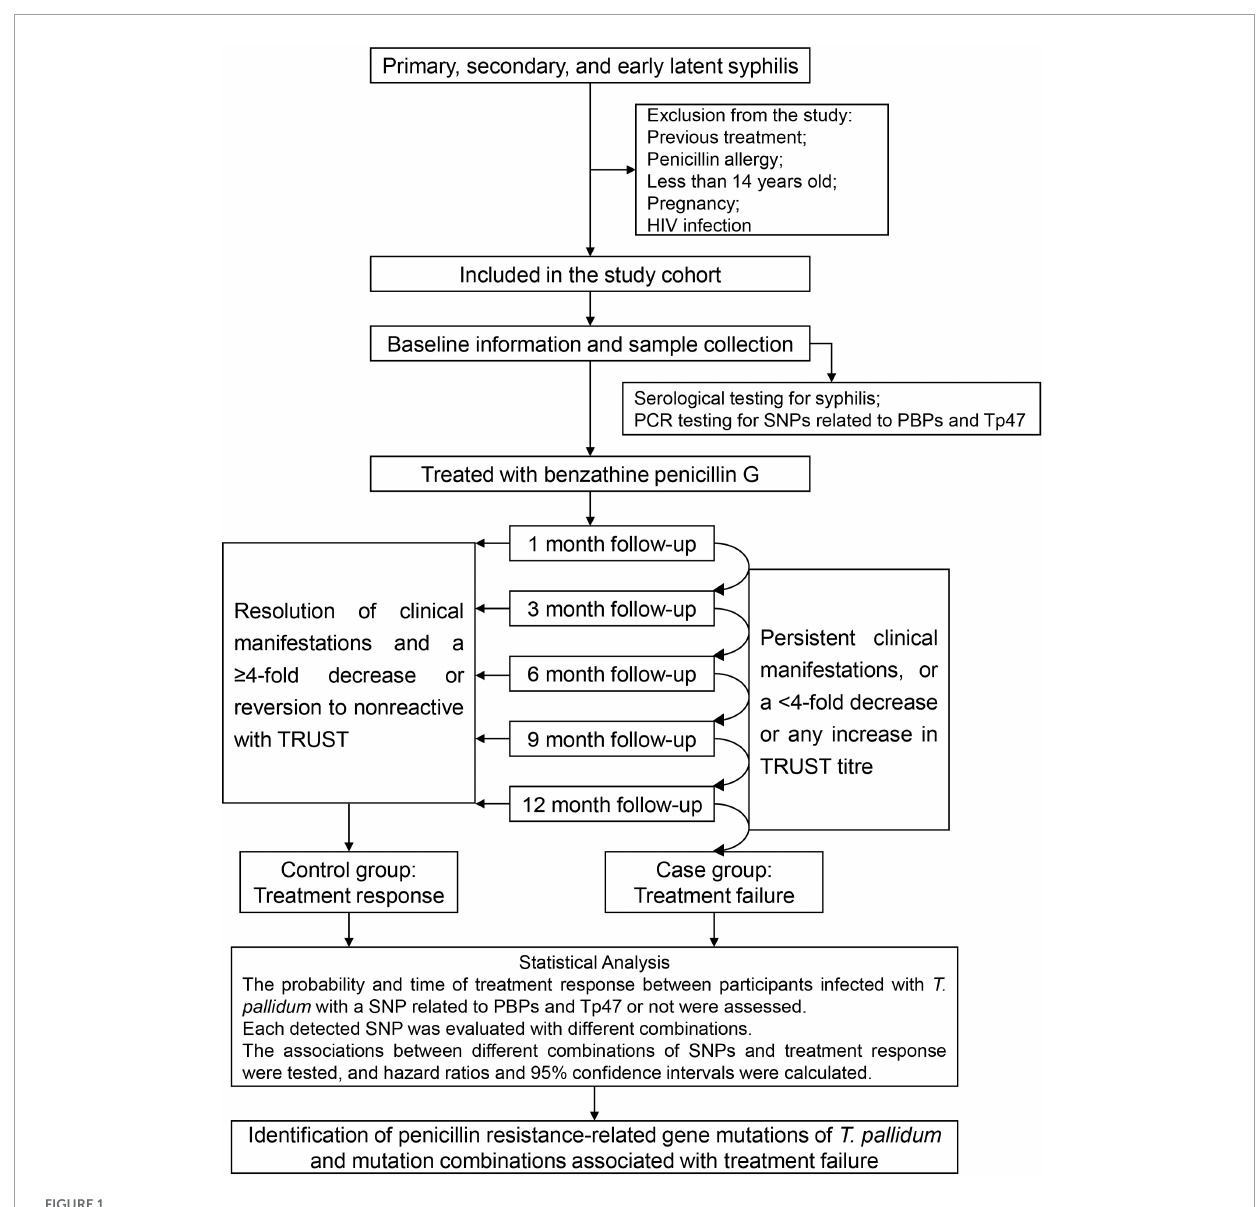
FIGURE1 Flow chart of the multicentre nested case–control study.